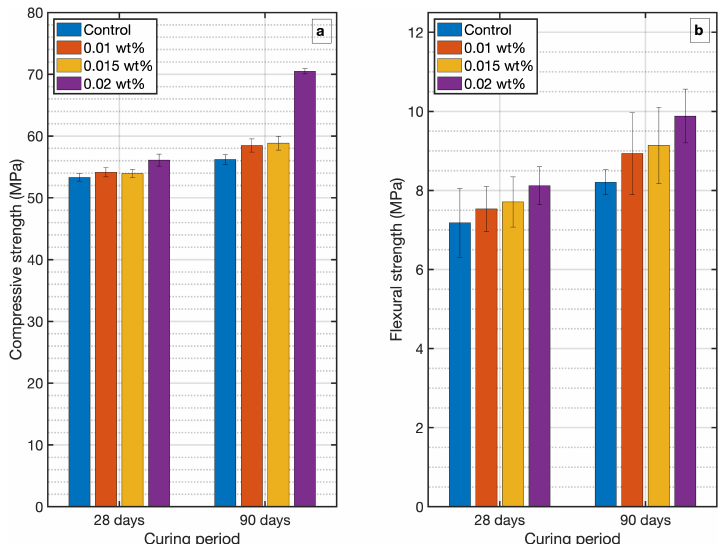
Figure 3. Compressive ( a ) and flexural strength ( b ) of MWCNT-mortar